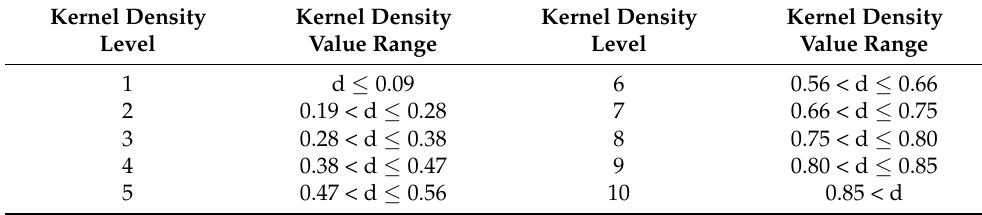
Table 2. Kernel density grading